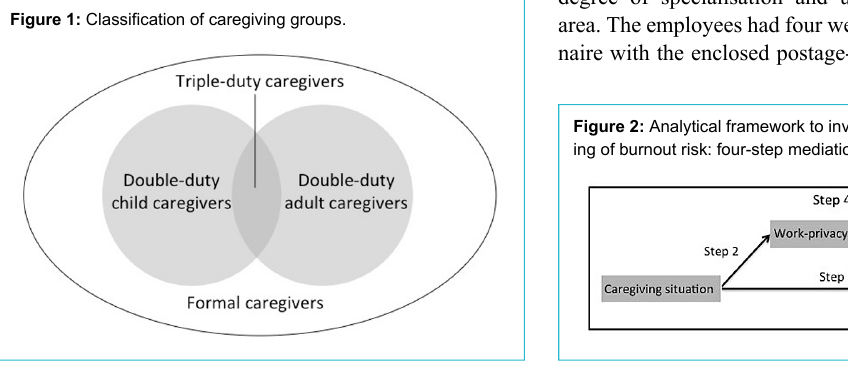
Figure 1: Classification of caregiving groups.